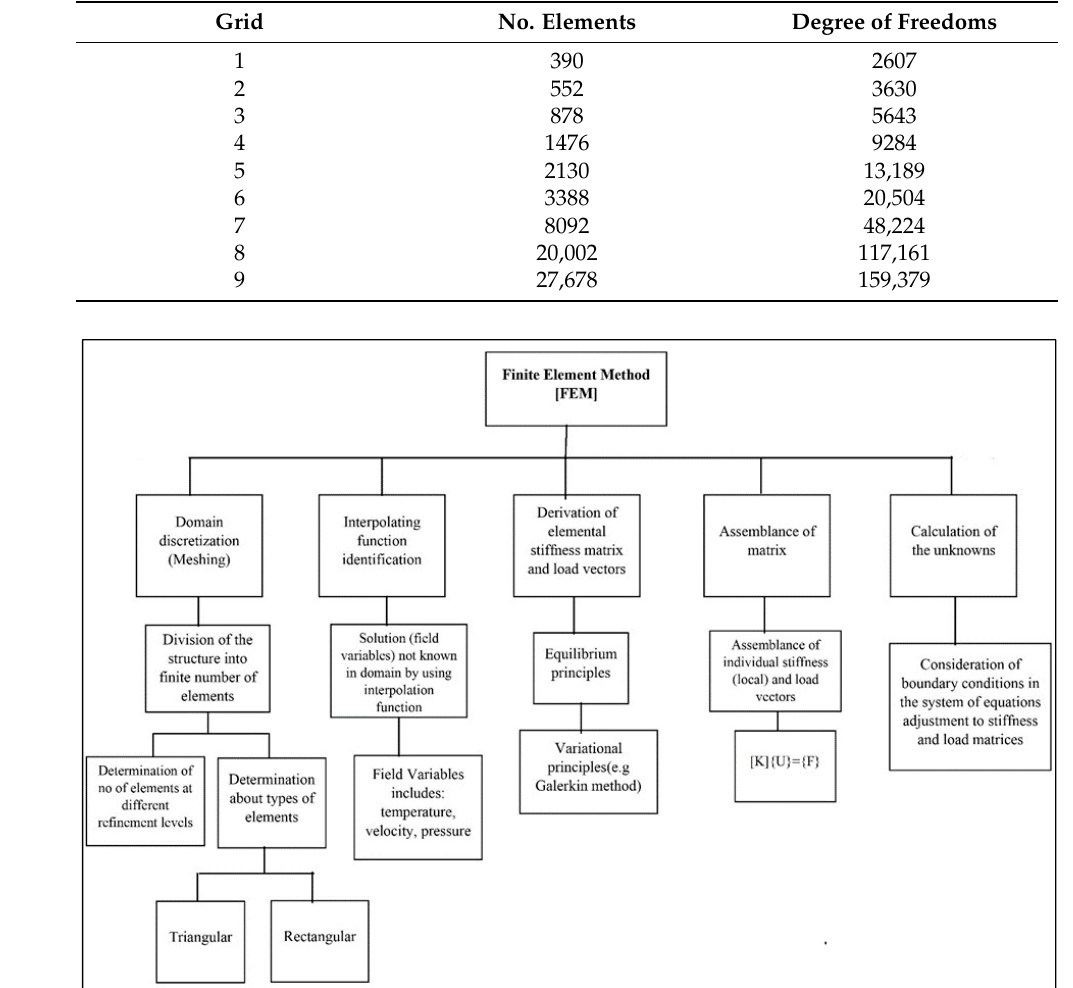
Figure 4. Flowchart for the finite element approach.